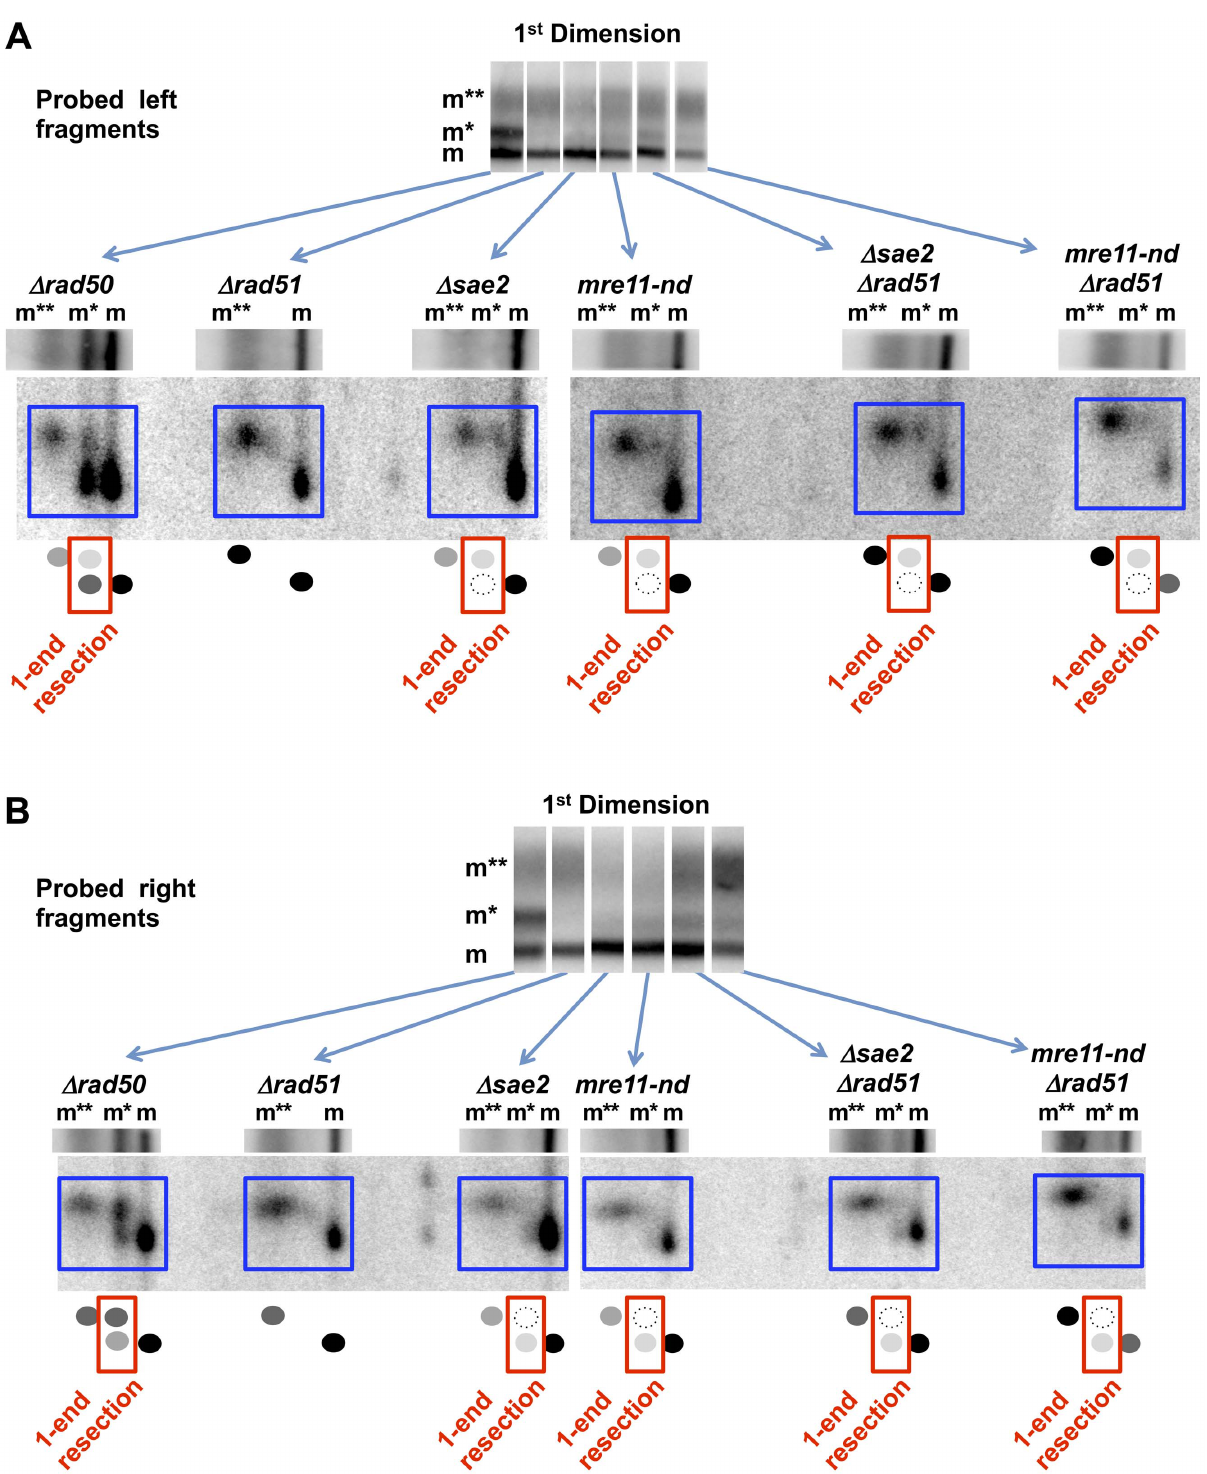
Figure 6. Resection at an I- Sce I DSB in D sae2,mre11-nd , D rad50 , and D rad51 single and double mutants. Resection at a ‘‘clean’’ I- Sce I DSB in the G2 D sae2 and mre11-nd cells is primarily 2-ended regardless of the presence of the D rad51 mutation, unlike for c -DSBs (see Figure 1 and Figure 4). However, resection at an I- Sce I break in the D rad50 mutant is primarily 1-ended (also see Figure 2). The small amount of 1-end resected molecules (m*) in the D sae2 and mre11-nd mutants is biased to resection at the left side of the break, while the 1-end resected molecules in the D rad50 mutant are biased to the right side. A. Left end probe. Note: D rad50 and D rad51 are also included in Figure 2E and are presented here for comparison. B. Right end probe. Note: D rad50 and D rad51 are also included in Figure 2D and are presented here for comparison.